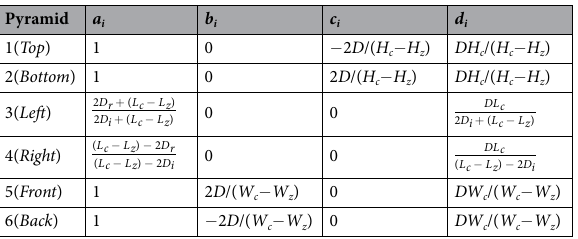
Table 1. The coefficients of the coordinate transformation for pyramid zone in the